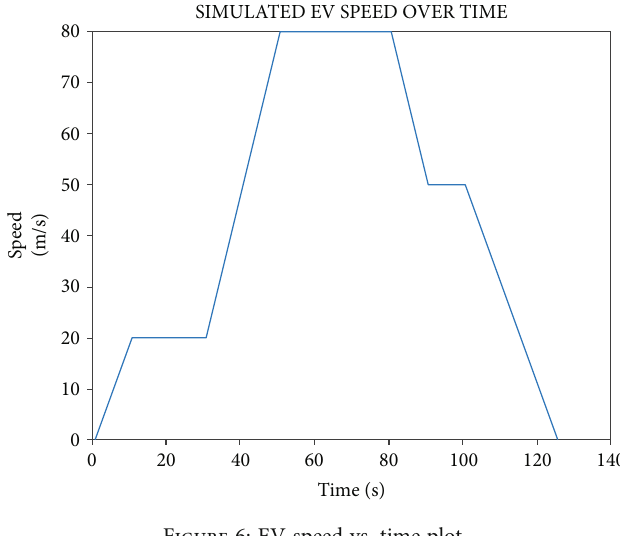
Figure 6: EV speed vs. time plot.